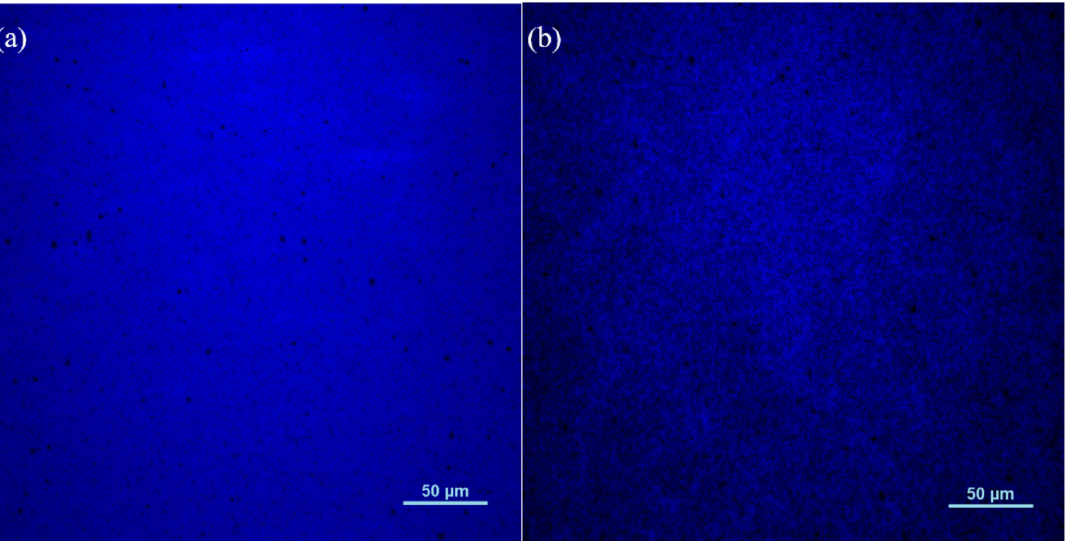
Figure 2. The micro-PL images of GaN-based MQW samples with two quantum wells ( a ) and eight quantum wells ( b